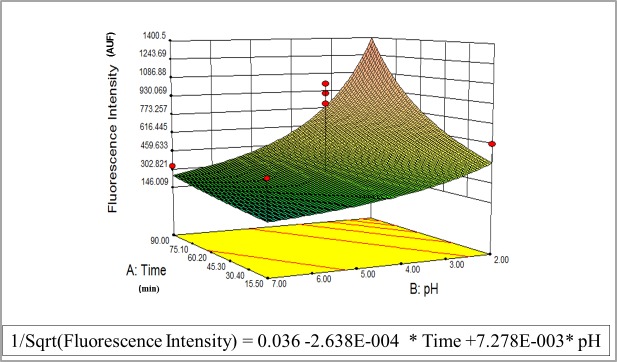
Analysis of FAM HP_LNA/2OMe_PS probe performance using the response surface methodology (RSM).Three dimensional surface plot showing the variation of H. pylori fluorescence intensity as a function of model terms. The model graphs are represented in gradient color shading. The surface is red at higher response levels and blue at lower ones.